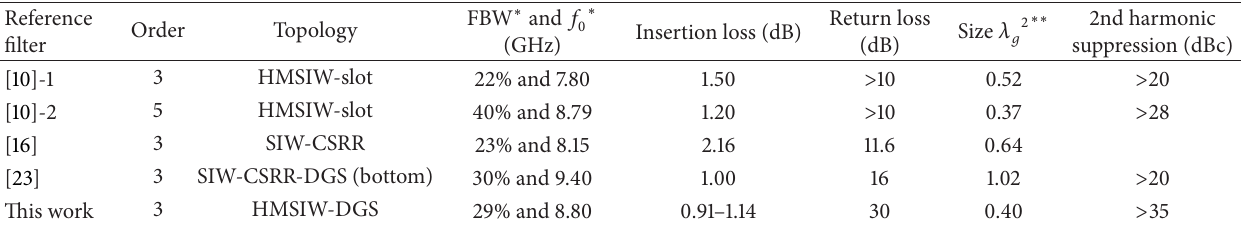
Table 1: Comparison with filters presented in references.